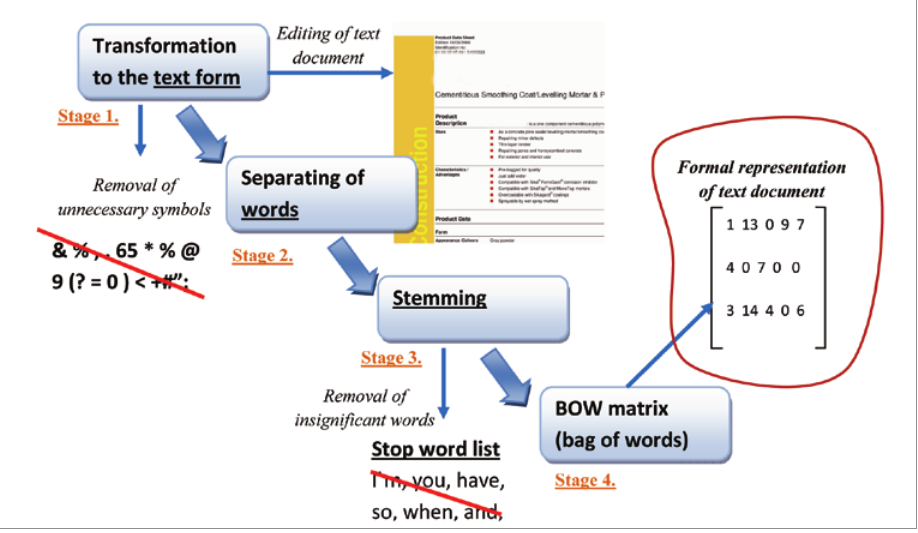
Fig. 3. Main stages of the text mining